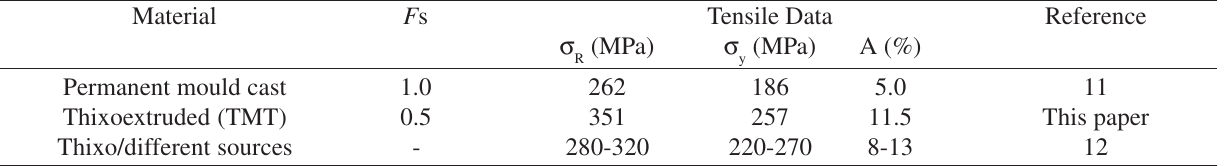
Table 3. Tensile Properties of A356 T6 Specimens, compared with Literature Data.